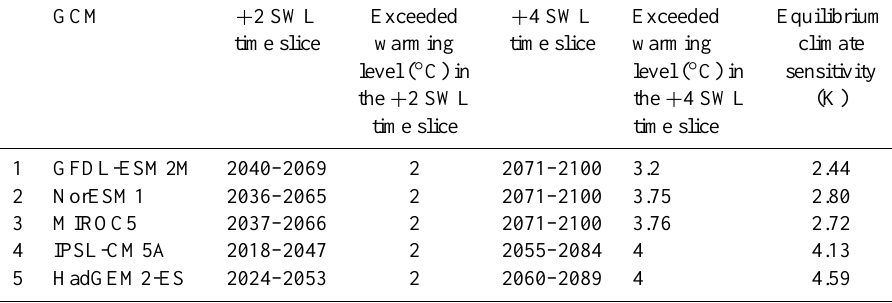
Table 1. Euro-CORDEX climate scenarios used to force JULES. GCM + 2